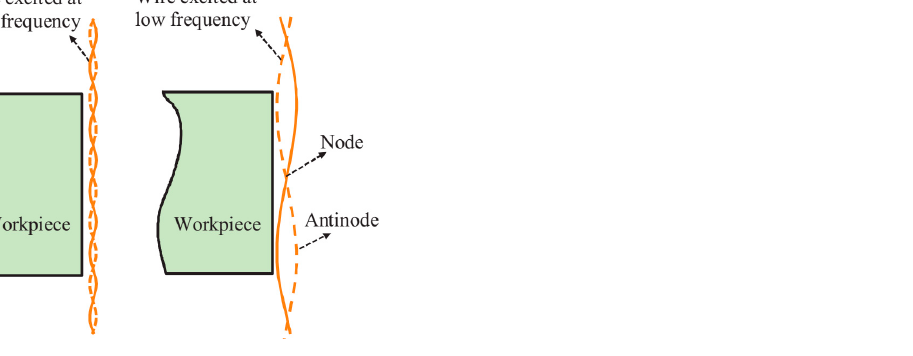
Figure 4 . Relationship between wire vibration amplitude and frequency during ultrasonic vibration - assisted WEDM . Table 1 . Element Compositions of Tungsten Carbide .